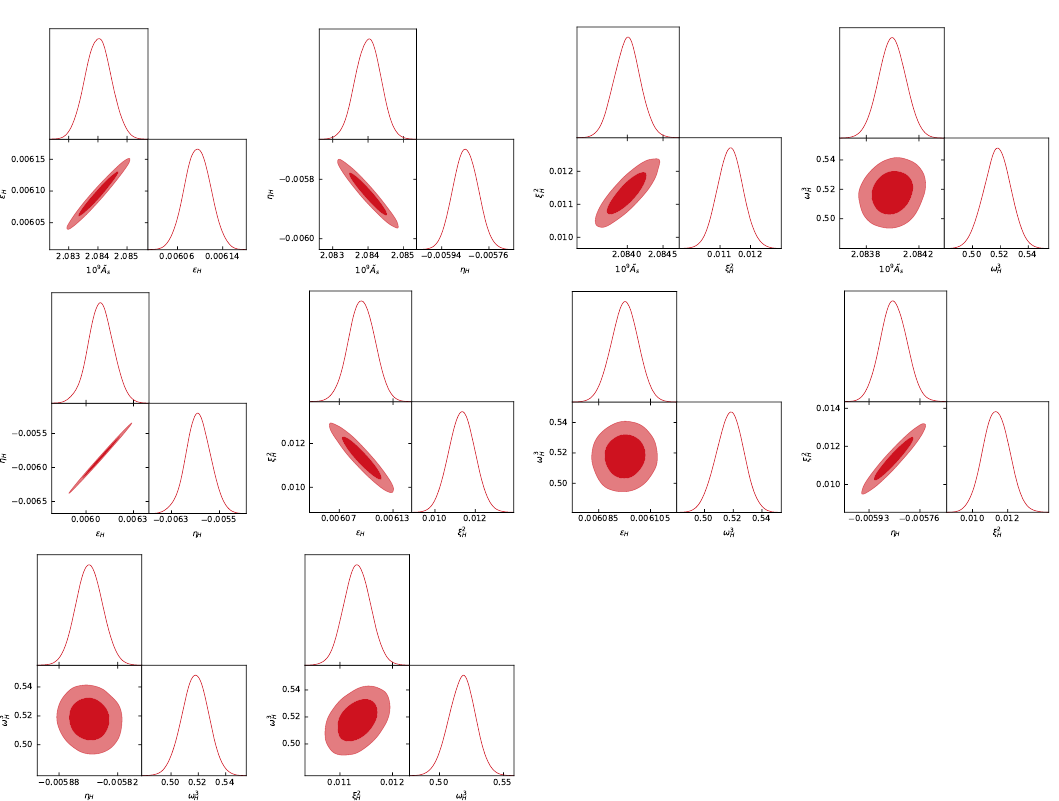
Figure 4: Sliced 2-dimensional likelihoods for the slow-roll parameters from SKA